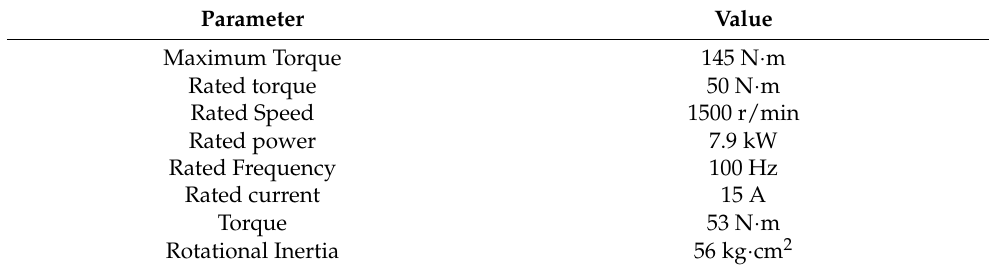
Table 3. Servo motor